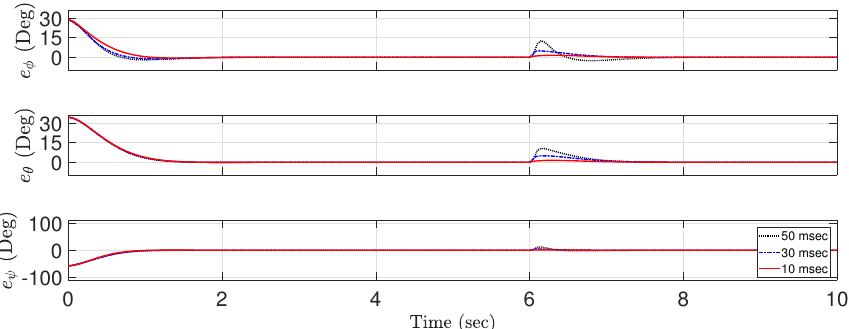
Figure 4. The trajectory-tracking performance of the proposed ETDC scheme in accordance with the sampling time 10 ms (solid line), 30 ms (dashed line), and 50 ms (dotted line).